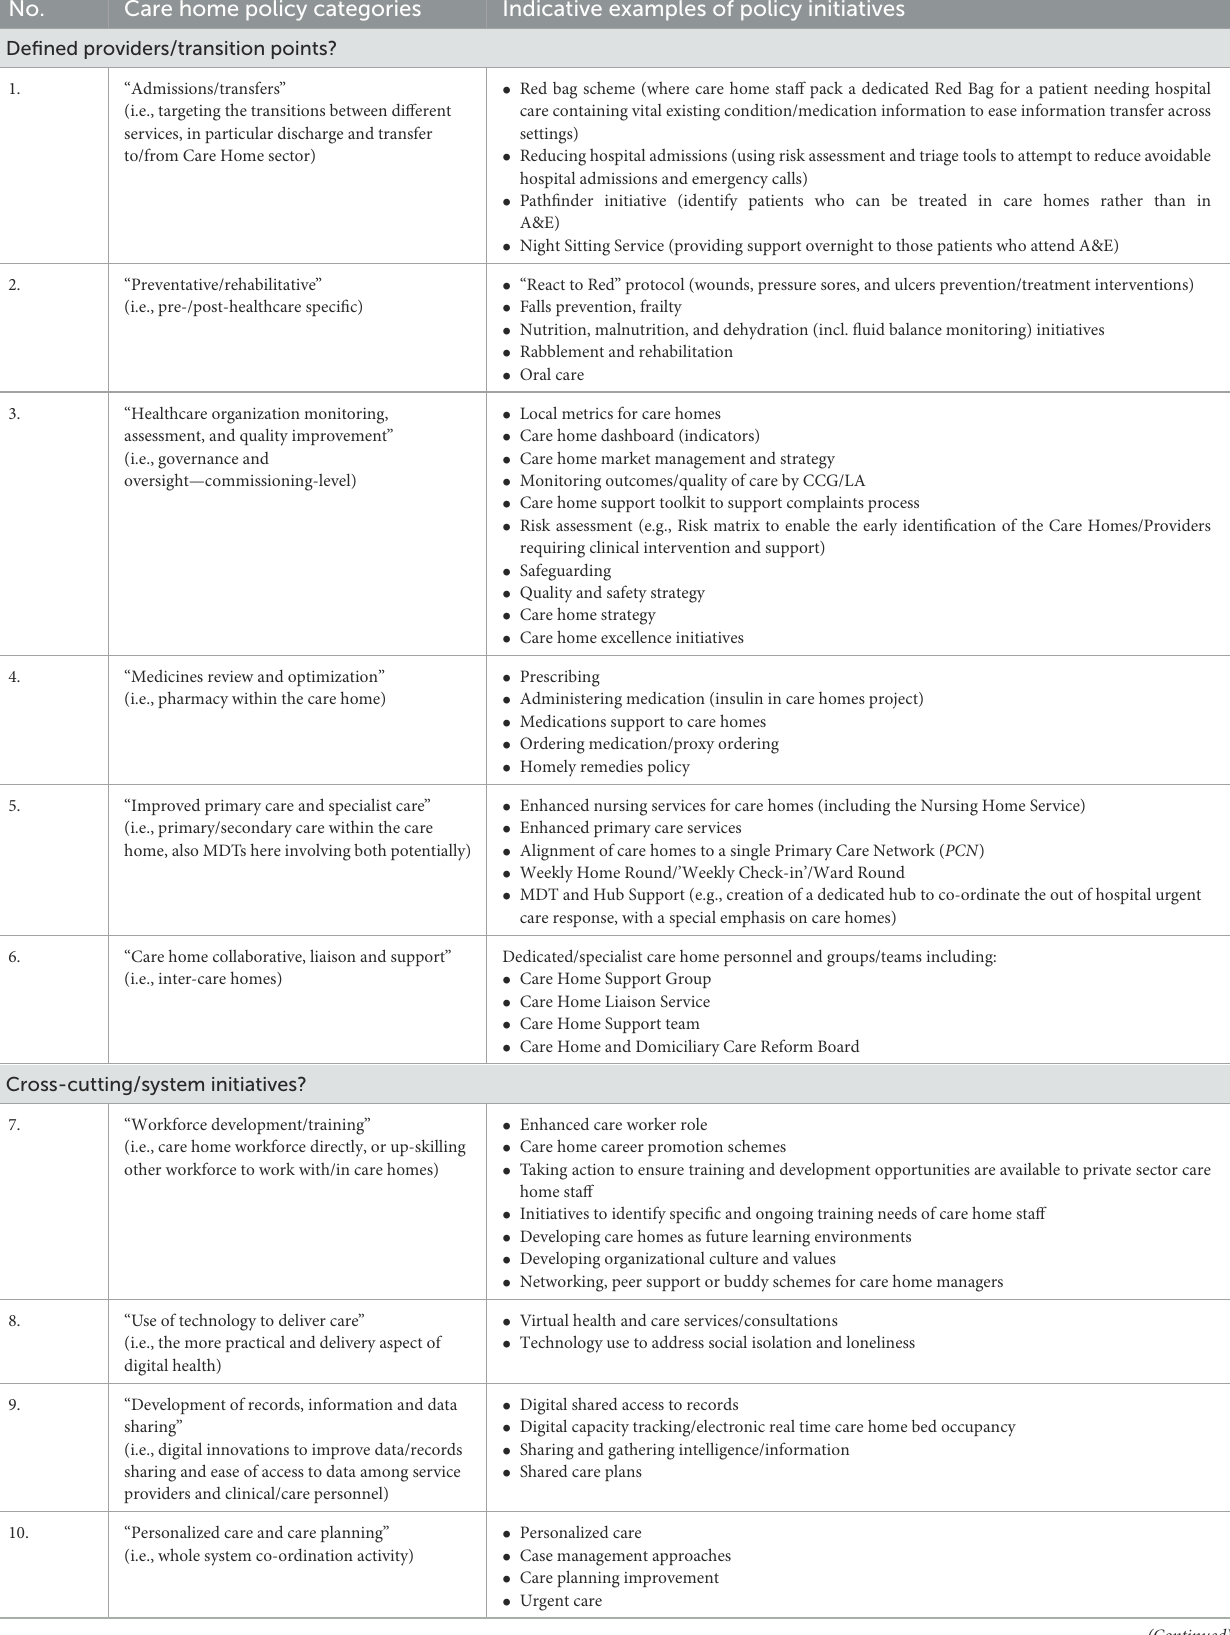
TABLE 2 A typology of care home integration policies and specific